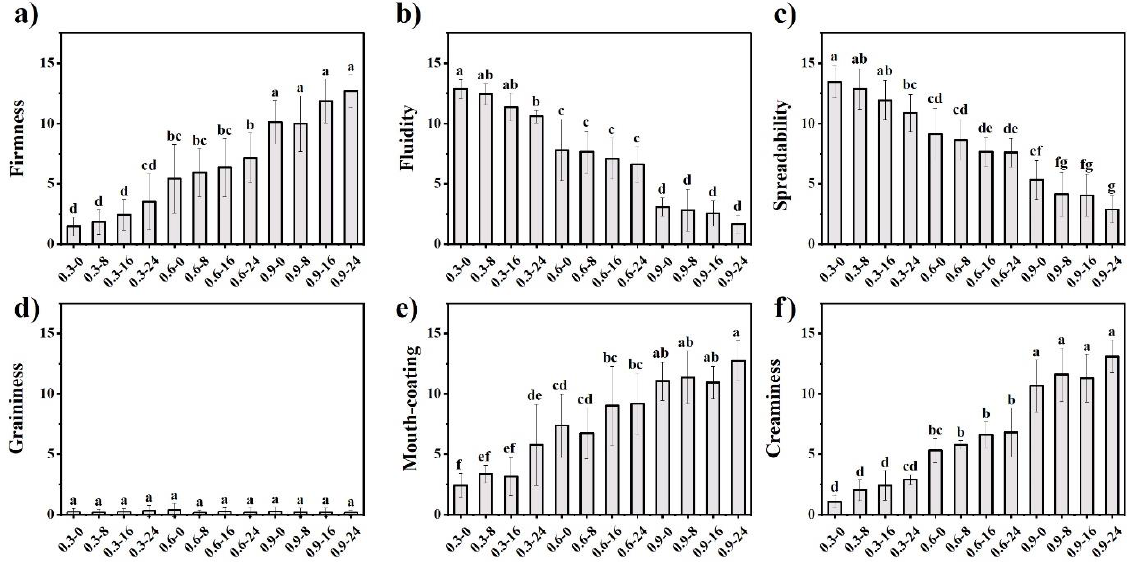
Figure 8. Sensory texture of low-fat model mayonnaises: ( a ) firmness, ( b ) fluidity, ( c ) spreadability, ( d ) graininess, ( e ) mouth-coating, ( f ) creaminess. Different letters above the bars indicate significant difference at p < 0.05. Table 3. Correlation between creaminess and extra- and intra-oral textural attributes.